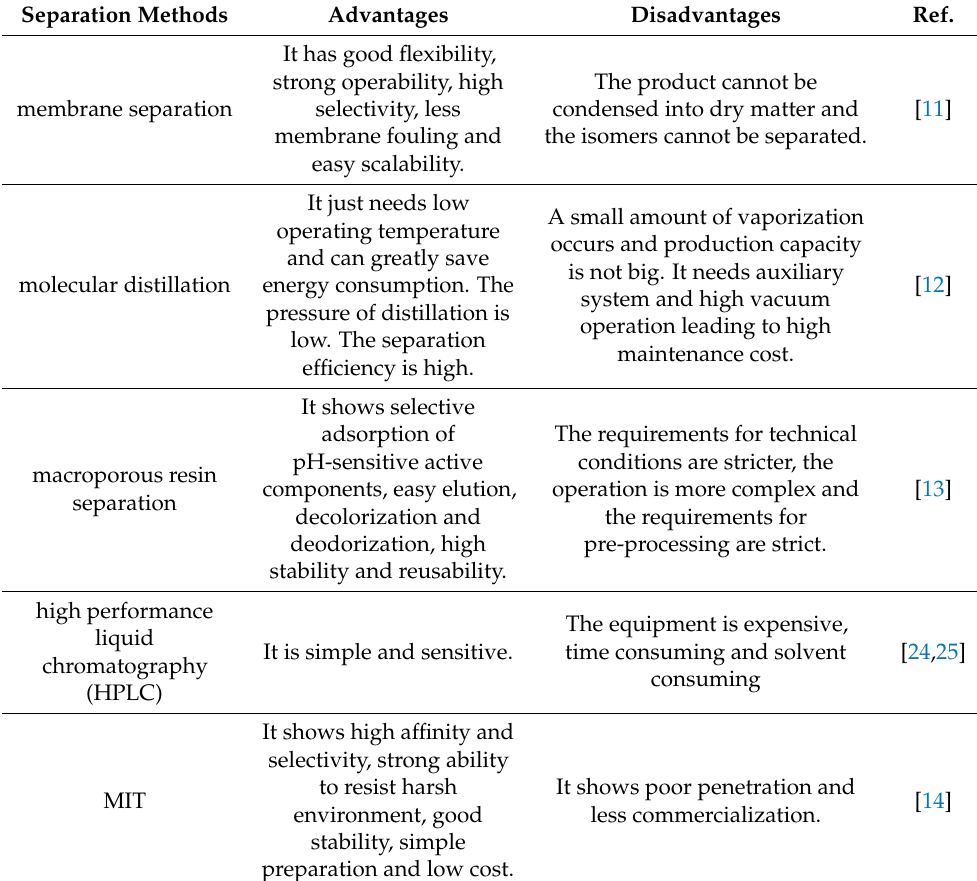
Table 1. Cont. Separation Methods